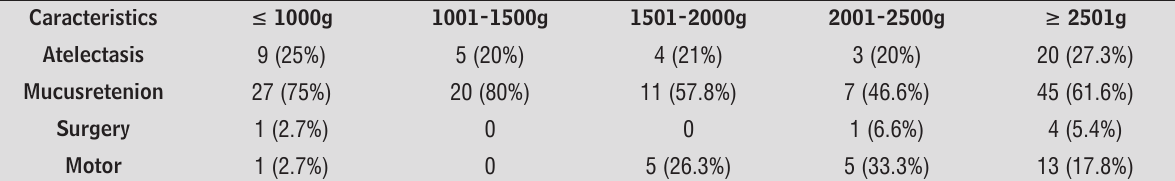
Table 3 - Reason for physical therapy request according to birth weight (g) Caracteristics